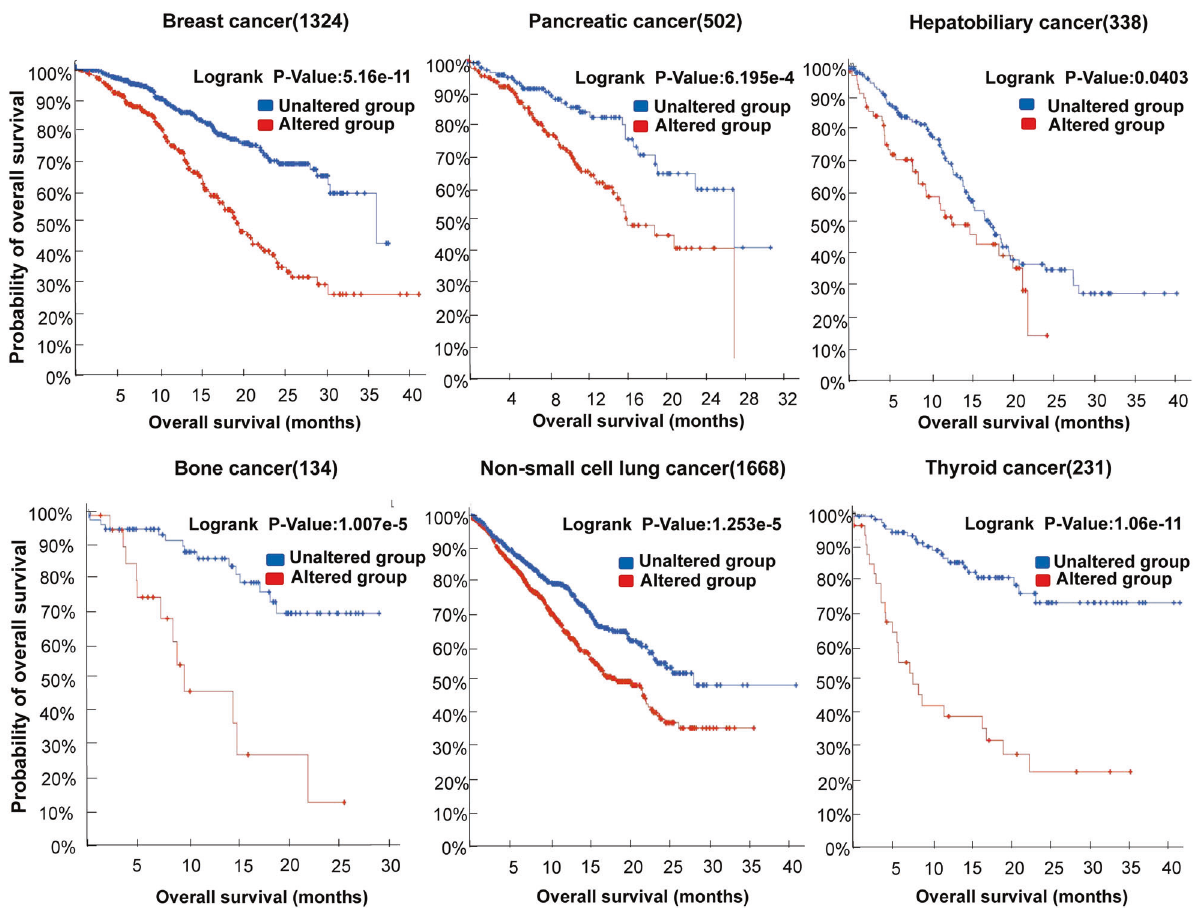
Fig. 2 Relationship between expression of mutp53 and overall survival in cancer patients. The relationship between mutp53 expression and overall survival in cancer patients. In some tumors,mutp53 expression is associated with poorer